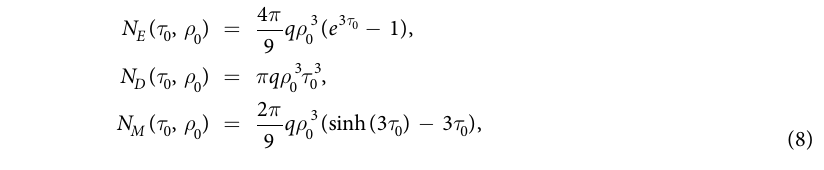
degree as a function of the rescaled sprinkling density q = δλ 4 and the rescaled temporal cutoff τ 0 = t 0 / λ , we get: